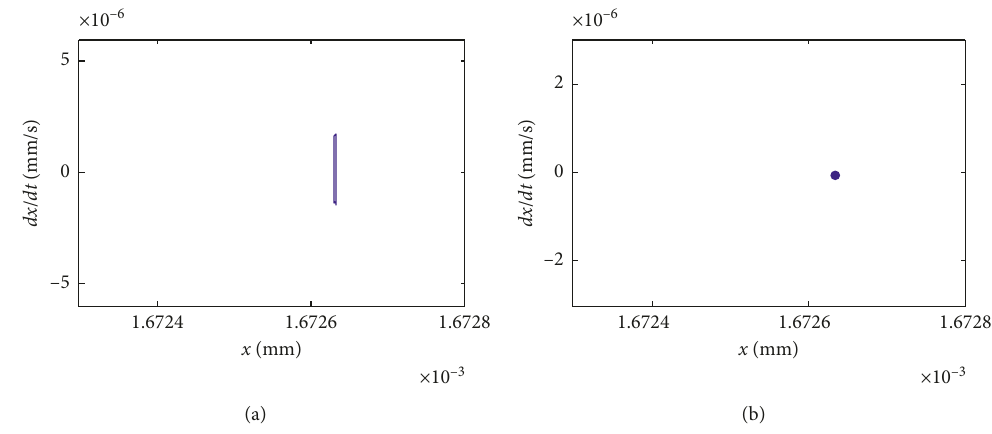
Figure 8: System response for ω � 5000r/min. (a) Phase portraits. (b) Poincar´e map.